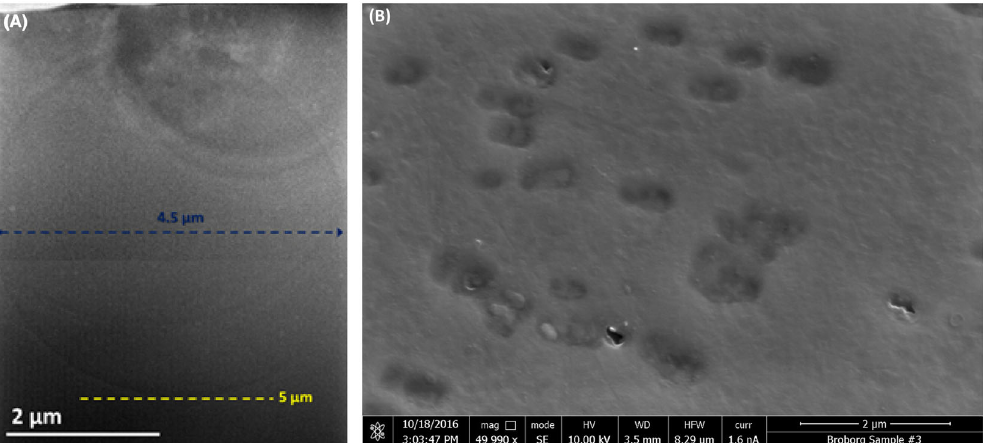
Fig. 5 Near-surface alteration of glass and pitting of glassy material from an ancient vitri fi ed Swedish Hillfort, Broborg. Samples 102 were analyzed with a FEI Helios NanoLab 660 (Hillsboro, OR) FIB-SEM with an energy dispersive spectrometer (EDS; EDAX Newark, NJ, example shown in image B ). An accelerating voltage of 5 kV – 10 kV, and a working distance of ~4 mm were used in the analyses. Image A was collected on a FIB sample with a JEOL ARM200F (JEOL, Peabody, MA) in scanning transmission electron microscope (STEM) mode operated at 200 keV. Image B was collected with an Everhart-Thornley secondary electron (SE) detector in fi eld-free conditions, and through-the-lens detectors (TLD) for SE and back-scatter electron (BSE) imaging in immersion mode using the above listed conditions. Images reproduced from Weaver et al. 99 . Left image was reproduced with permission from 102 , copyright (John Wiley and Sons,